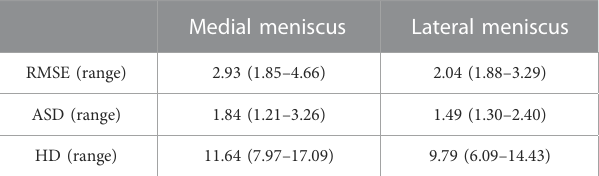
TABLE 9 Median RMSE, ASD and HD with range for the medial and lateral meniscal course. Medial